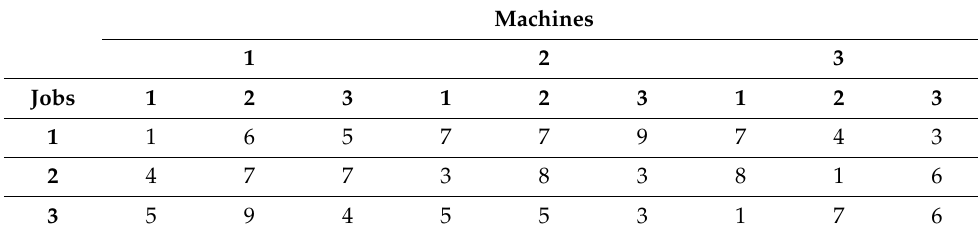
Table 2. The sequence-dependent setup times between the pair of jobs on each machine.